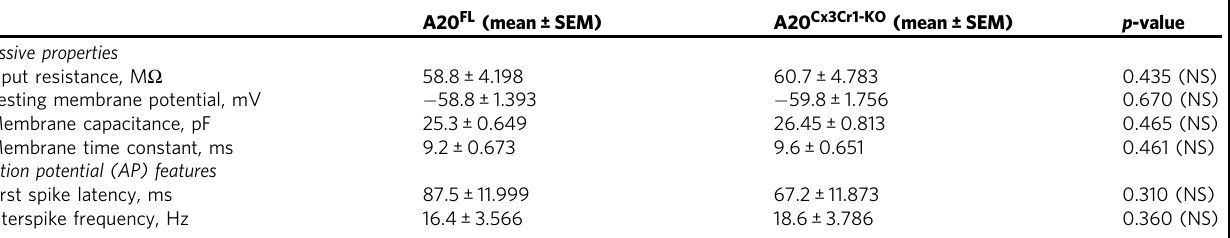
hyperproliferation (Fig. 1), no further effect on microglia pro- liferation is seen after LPS (Fig. 3d). Microglia morphology analysis 10 h post LPS suggests a reactive phenotype in A20 Cx3Cr1-KO mice compared with wild-type littermates, as